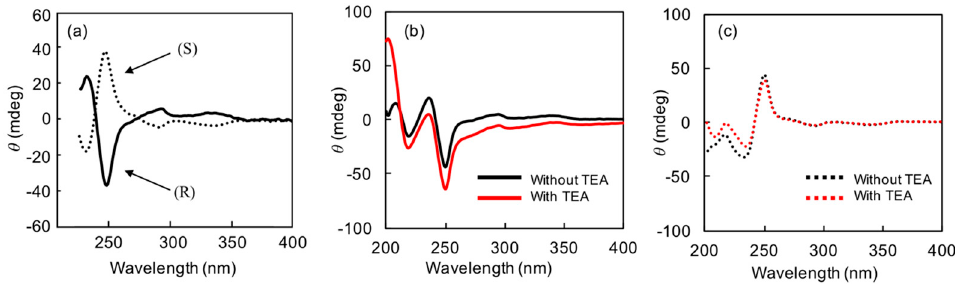
Figure 4. ( a ) CD spectra of BD alone. The effect of TEA on the enantioselective responses of ( b ) R-BD and ( c ) S-BD in the presence of G -CA. Solvent: 95:5 (v/v) methylcyclohexane:THF. Concentrations: G -CA, 0.75 mM; BD, 0.05 mM. Temperature: 0 °C.